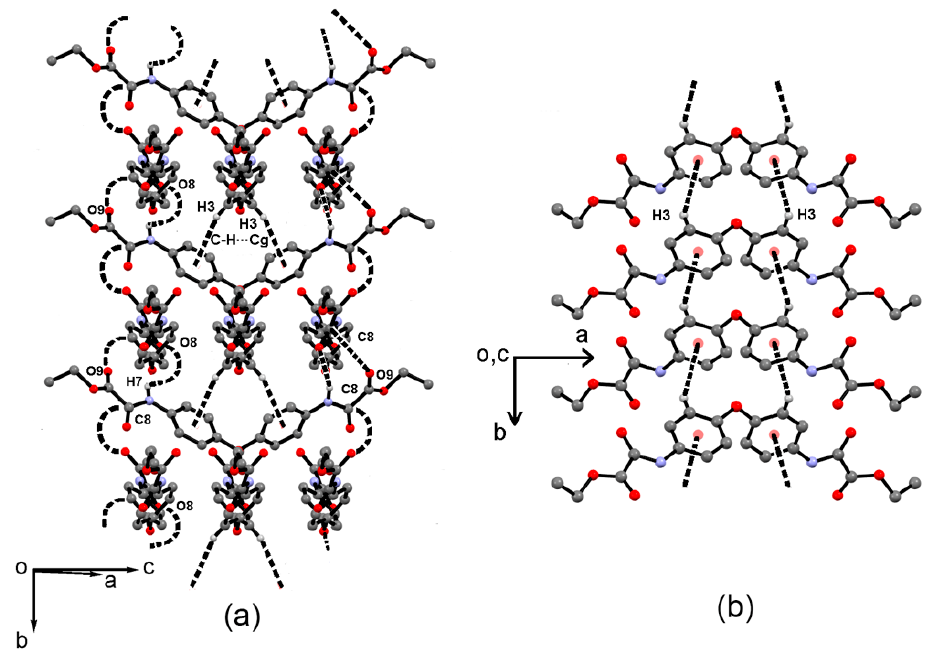
Figure 7. ( a ) Supramolecular cross-linked tape formed by 3:1 units of 2 running along the b axis. ( b ) C-H ··· π interactions in 2 .